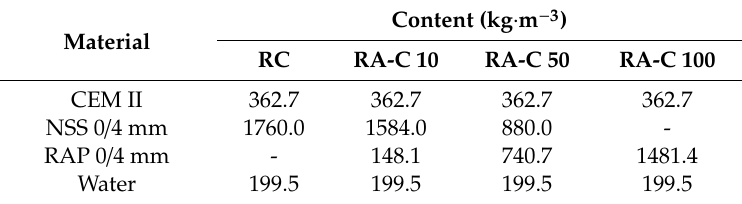
Table 3. Composition of produced